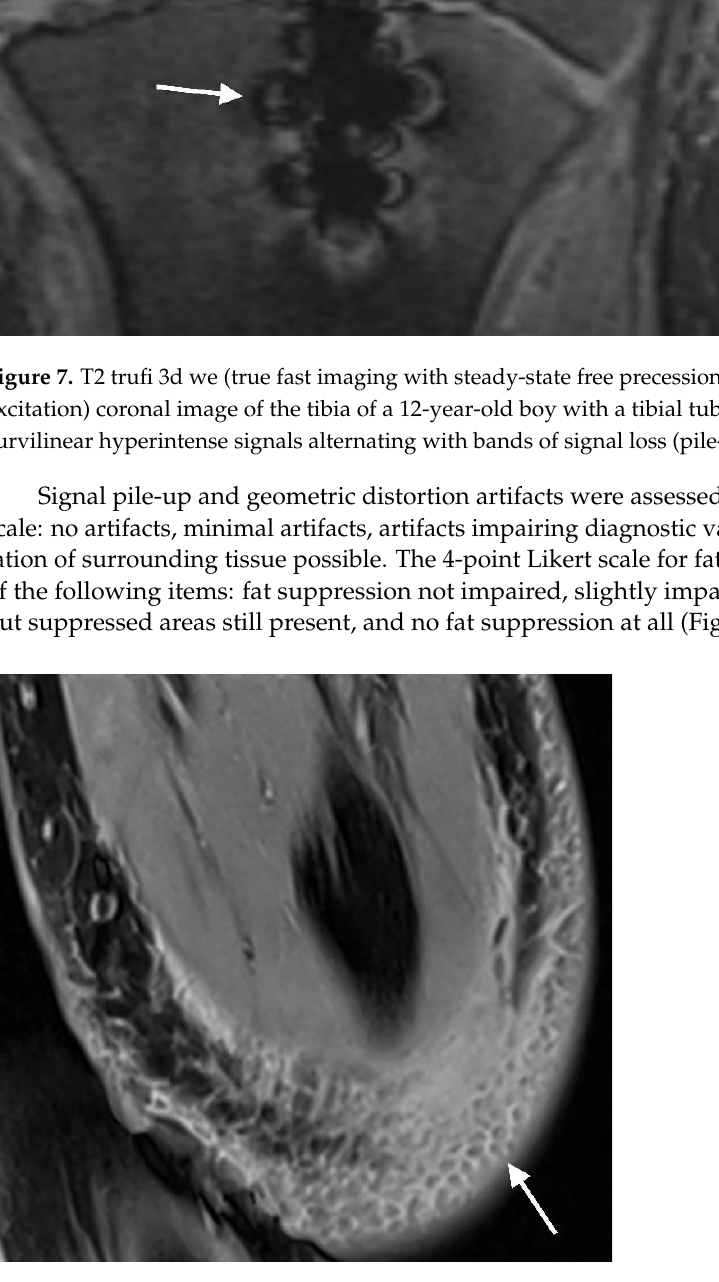
Figure 8. PD tse fs (proton density turbo spin echo fat-saturated) transverse image of the left elbow of a 14-year-old boy with an intercondylar humerus fracture. DIXON fat suppression, visible in the hypointense subcutaneous fat lobules surrounded by hyperintense soft tissue edema (arrow), is unaffected by the magnesium screw and gas (both not visible on this slice).